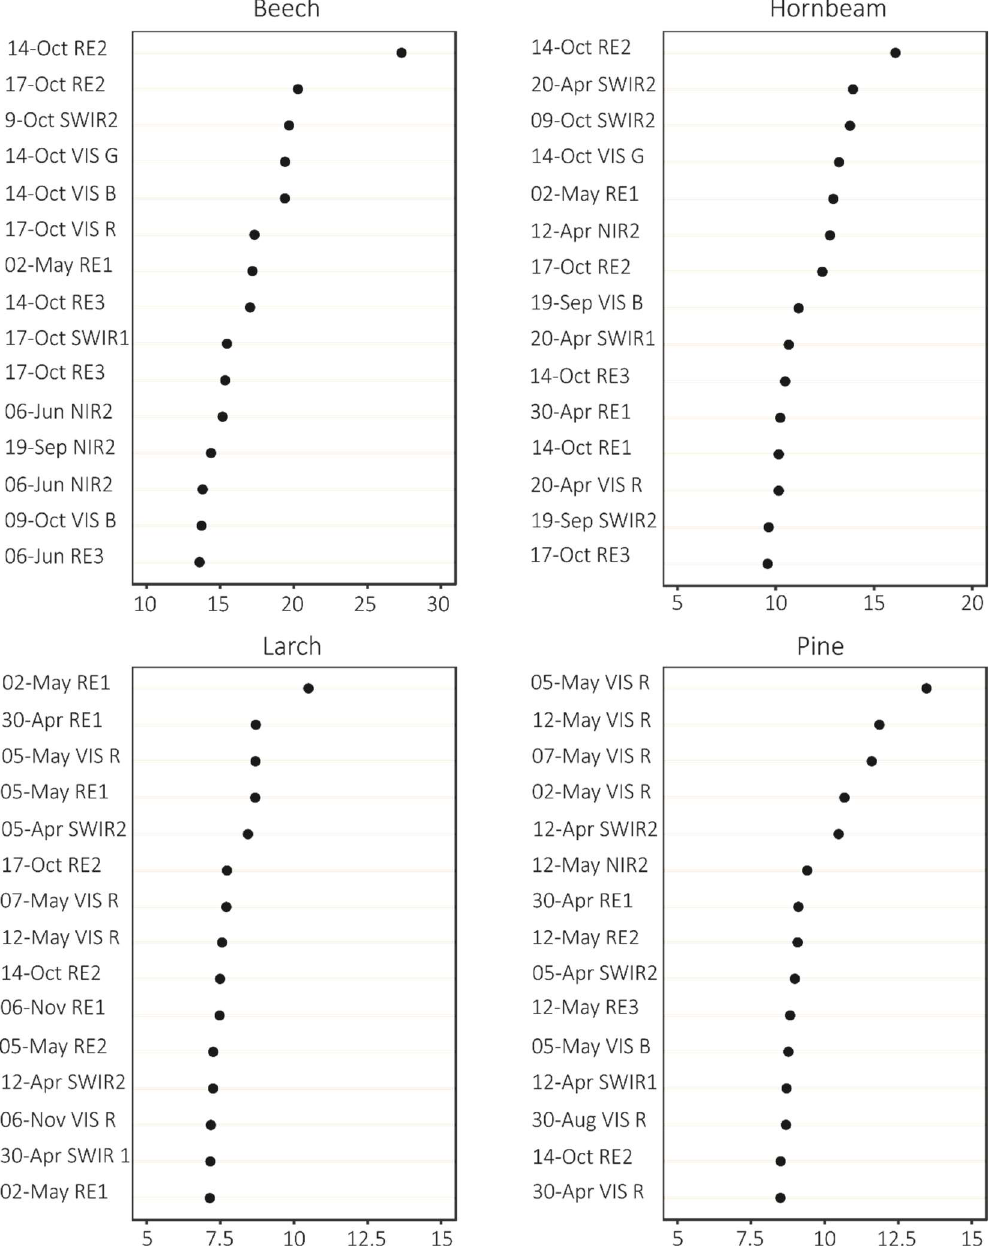
Figure 5. Fifteen most important variables for tree species classification regarding selected species (MDA statistics).